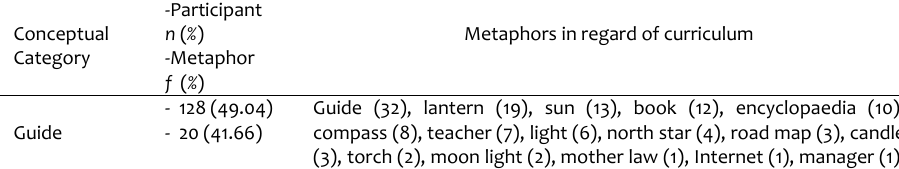
Table 2 . Conceptual categories regarding